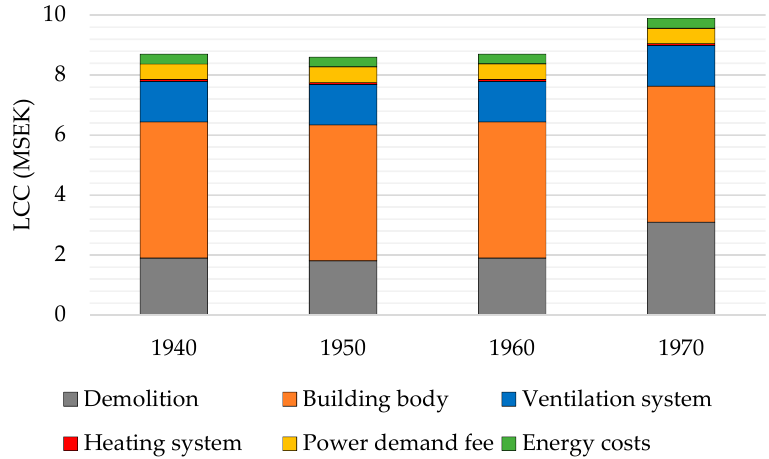
Figure 8. LCC for the demolition and construction of a new building for the buildings from the 1940s, 1950s, 1960s, and 1970s. 55